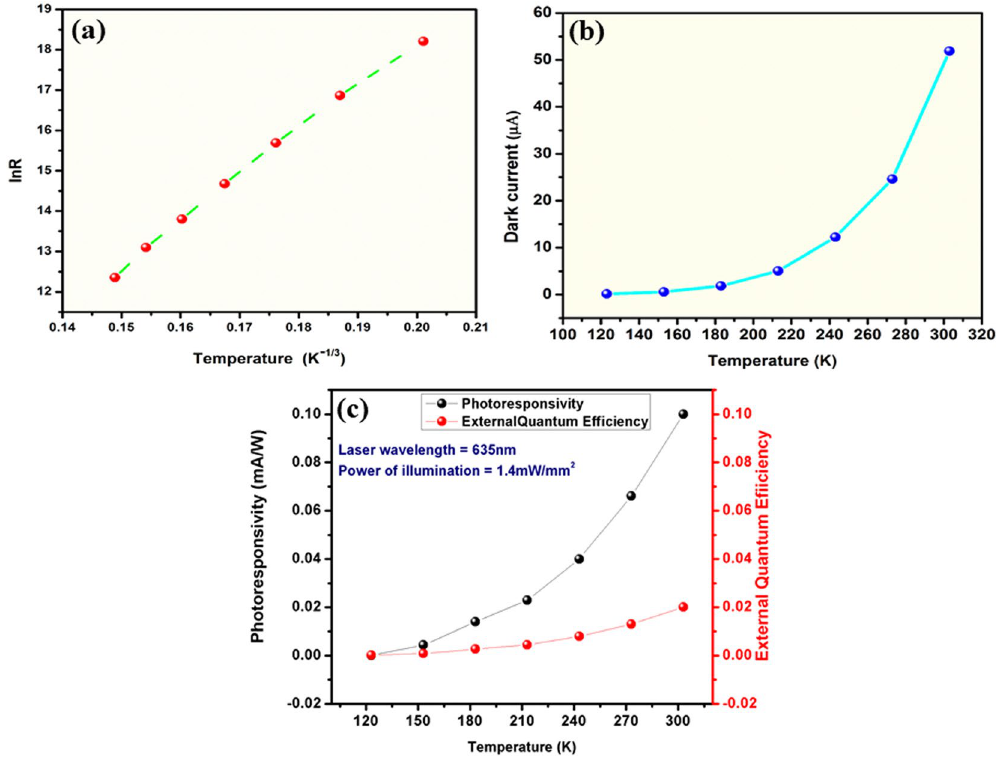
Figure 7. Temperature dependence of ( a ) electrical resistance, ( b ) dark current, and ( c ) photoresponsivity and external quantum efficiency of rGO